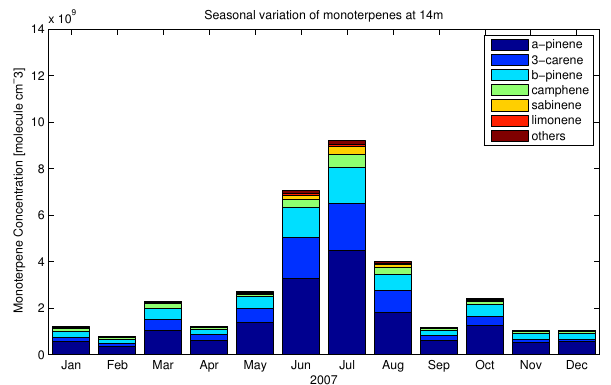
Figure 11. Modelled (MEGAN 2.04) distribution of individual monoterpene concentrations at 14 m height for the year